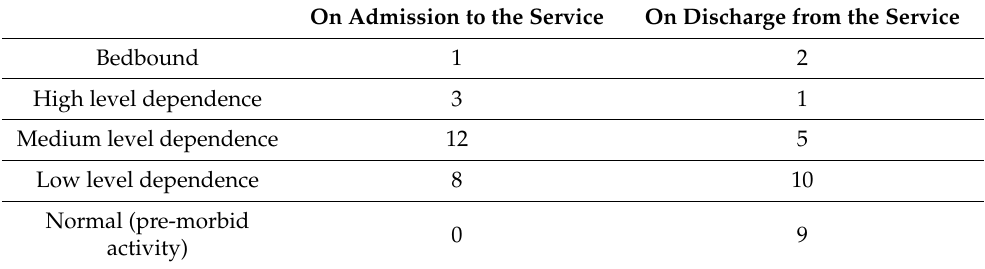
Table 7. Participation in physical